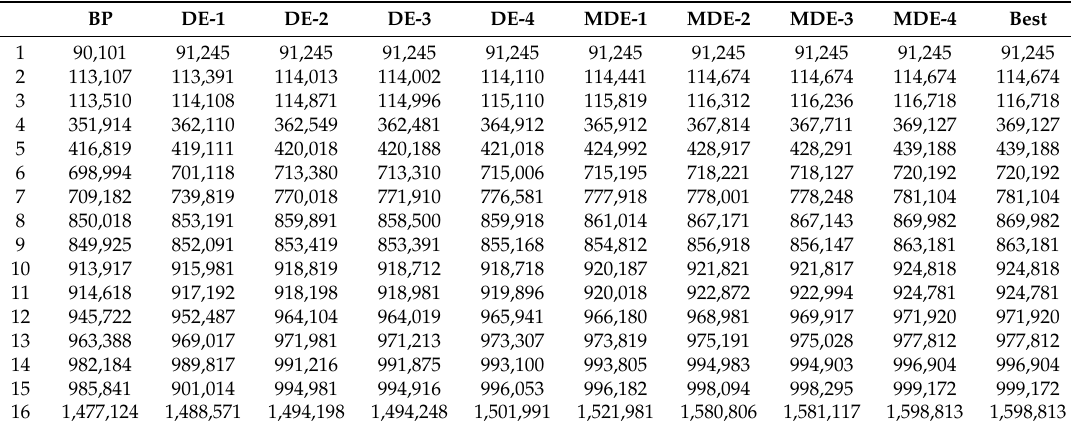
Table 16. Profit generated in 90 min using different methods. “Best” Best is the best solution amongst all compared heuristics.